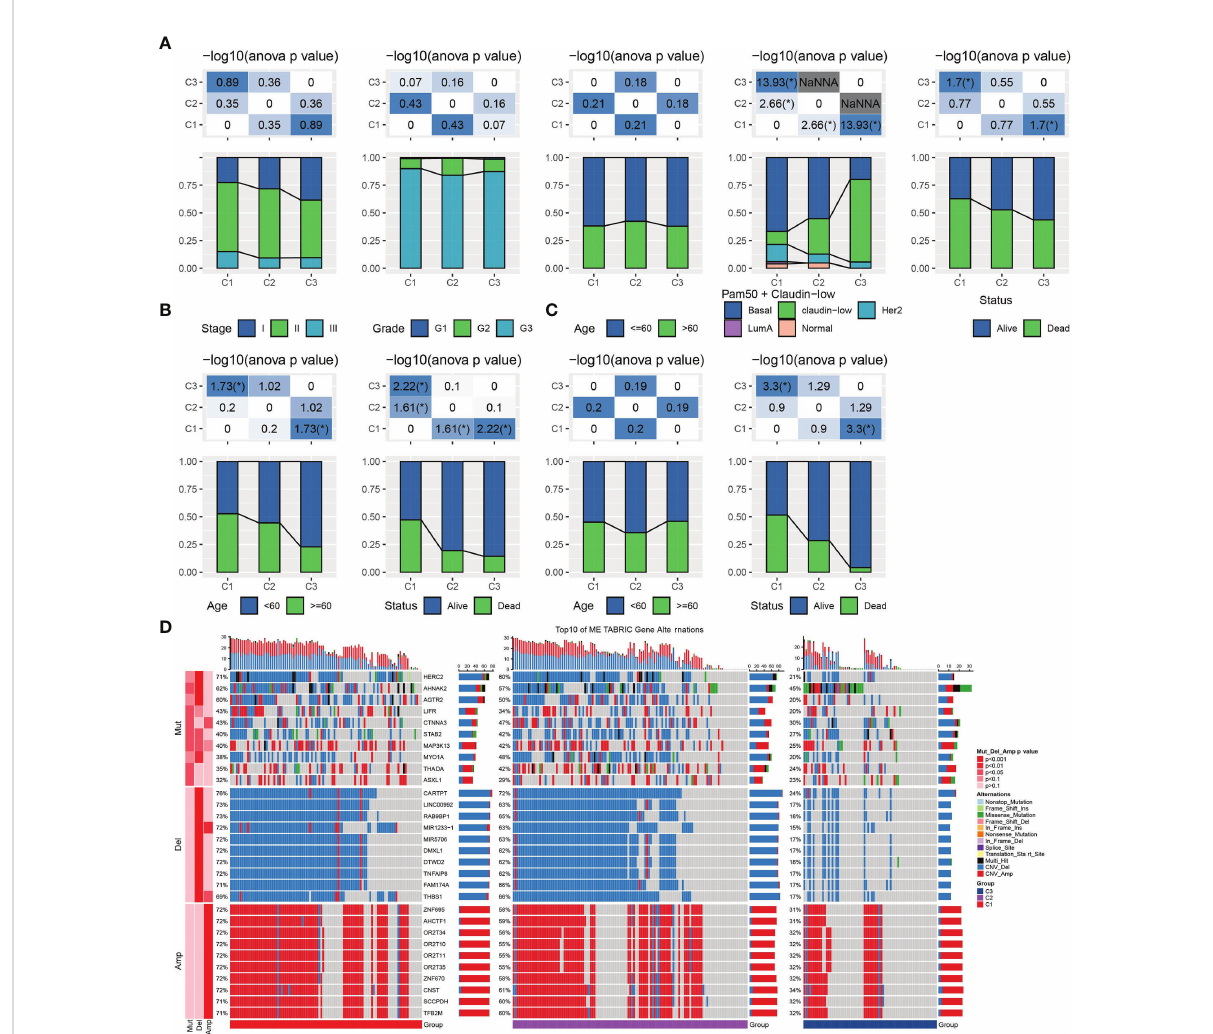
FIGURE 3 Clinical characteristics and Genomic alteration of the LR pairs-based molecular subtypes. (A) The distribution proportion of stage, grade, age, PAM50+claudin-low molecular subtypes and survival status in each subtype of METARIC database. (B) The distribution proportion of age and survival status of each subtype in the GSE588123 cohort. (C) The distribution of age and survival status among the three subtypes in GSE21653 data sets. (D) Waterfall map of somatic mutation and CNV in three subtypes of METARIC database in we had assigned, chi-square test. A symbol "*" indicates ANOVA p <